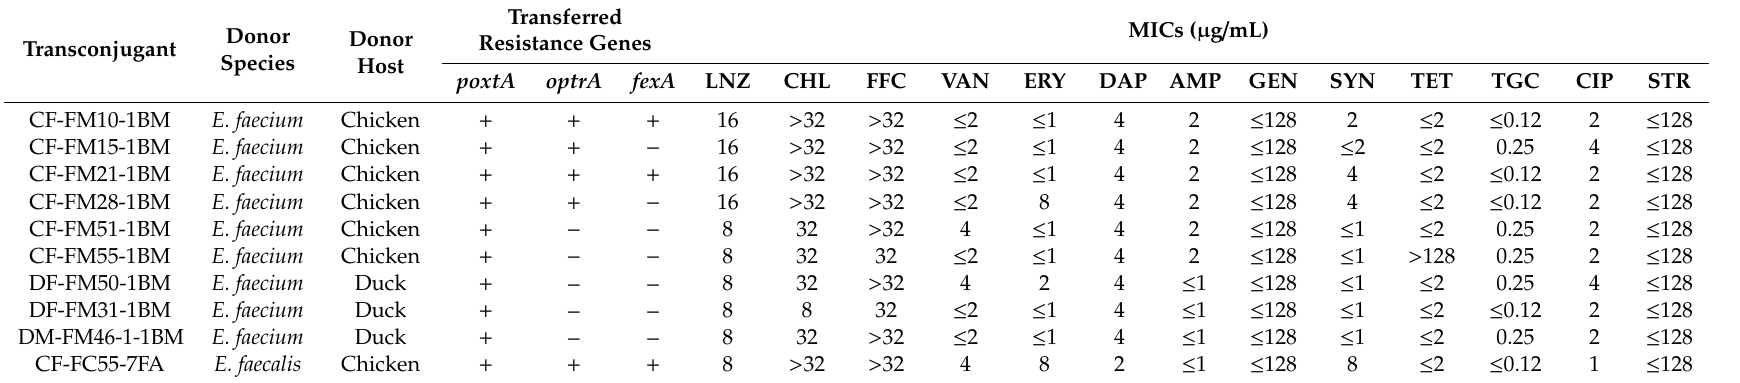
Table 3. Characteristics of Enterococcus faecium and E. faecalis transconjugants carrying poxtA gene a